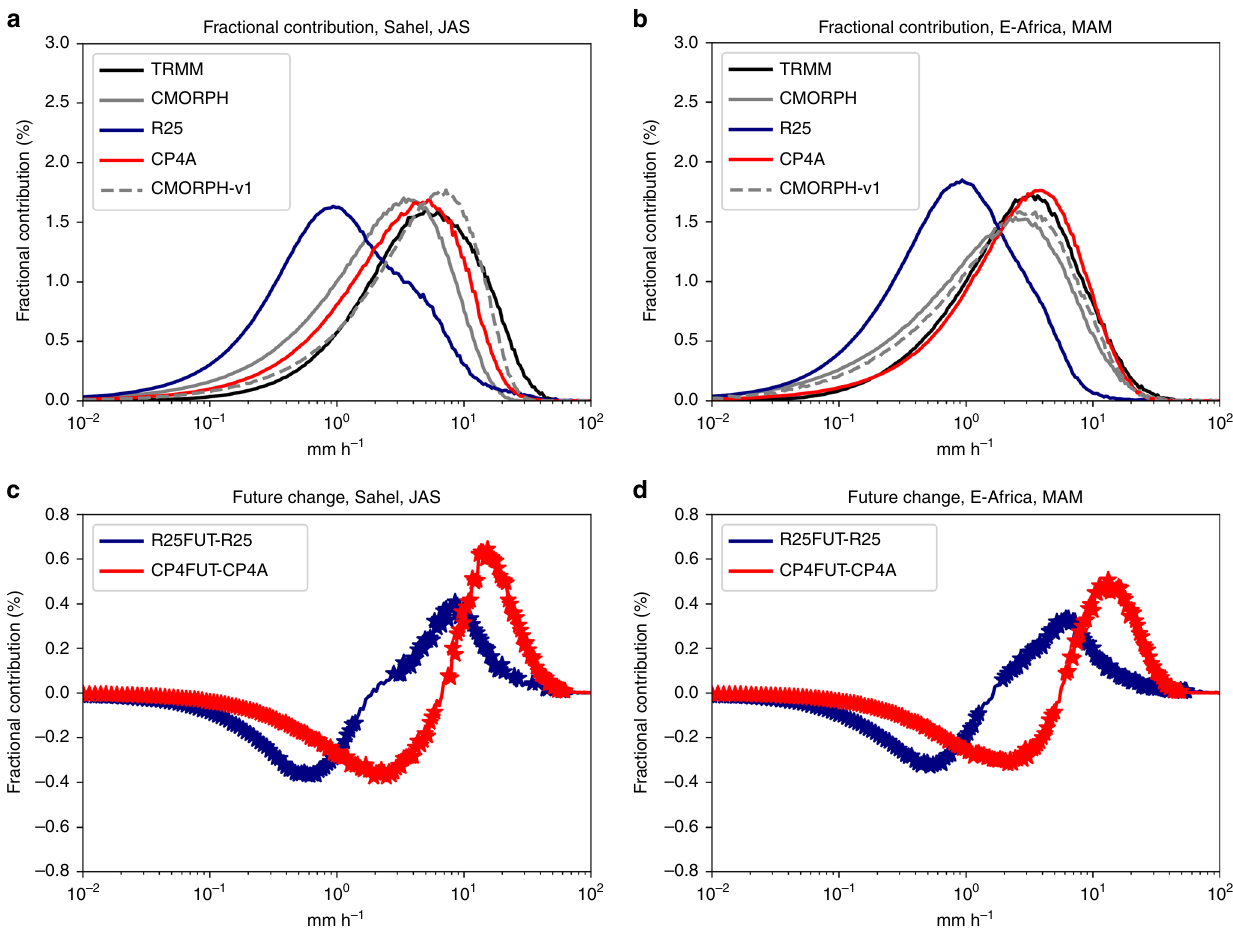
Fig. 7 Fractional contribution of 3-hourly precipitation intensity bins to the total precipitation. a , b Fractional contribution (%) for present day for TRMM and CMORPH observations and R25 and CP4A models; c , d difference in fractional contribution between 2100 and present day for R25 and CP4A models dashed) is shown as well as the bias-corrected data (CMORPH, grey solid). Regions are as shown in Fig. 6. All 3-hourly data in the given season, in the 10-year period, from all land points in the sub-region are used to calculate the fractional contribution. Stars indicate where future changes are signi fi cant at the 1% level compared with year-to-year variability, assessed using bootstrap Methods models them using an adaptation of the vegetation canopy code. The regional Models . The models used here are all con fi gurations of the Met Of fi ce Uni fi ed models treat lakes as sea points, and hence it is necessary to provide them with a Model (UM). The 4.5-km CP4A model spans the African continent, and is driven by a N512 resolution global climate model (GCM). It is based on the UKV Met from this dataset is used in both the CP4A and R25 models. For other inland lakes Of fi ce regional model that has been in use for operational numerical weather (typically those with a surface area of less the 50 km 2 ), a surface temperature value prediction since 2012. The model physics and dynamics used in CP4A have been described previously 19 . The 25 -km regional model (R25) and global model, both have the same physics con fi guration: a prototype version of the UM Global Atmosphere 7.0 (GA7) con fi guration 38 (GA7 is the atmospheric component of the Global Coupled Model 3.0 which is the UK ’ s submission to CMIP6 39 ). R25 has the same domain, land surface and aerosol forcing as CP4A and is similarly forced by the N512 GCM at its lateral boundaries. The key physics differences between the CP4A and R25 models are that in CP4A the convective parameterisation scheme is switched off, a different cloud scheme and a blended boundary layer scheme are used, and moisture conservation is applied 19 . Soil moisture evolves freely using the JULES land surface scheme 38 . CP4A and R25 use the same land-surface properties, and in particular the soil properties are de fi ned to be spatially uniform (and those of sand) across the whole domain. This differs from the driving GCM that uses the Harmonized World Soil Database, which is considered to contain unrealistic small-scale variability across Africa 40 . In both CP4A and R25, the soil moisture fi elds were initialised with data derived from an off-line JULES simulation 19 . In the present-day simulations, all models are forced with sea surface temperatures (SSTs) from the Reynolds daily observations 41 . Lakes are treated differently in the two regional models compared with the N512 global model. In the global model, only Lake Victoria is modelled as a ‘ sea point ’ in the land sea mask; all other lakes are land points and treated as inland water by JULES, which